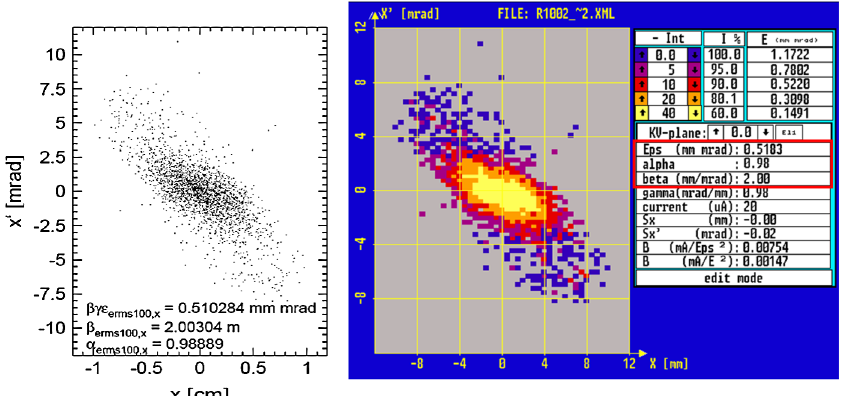
FIG. 5. (Color) Transformation of format of a distribution from DYNAMION simulation (left) to the format of measured data (right). Normalized 100%-rms-Twiss parameters are highlighted in red.